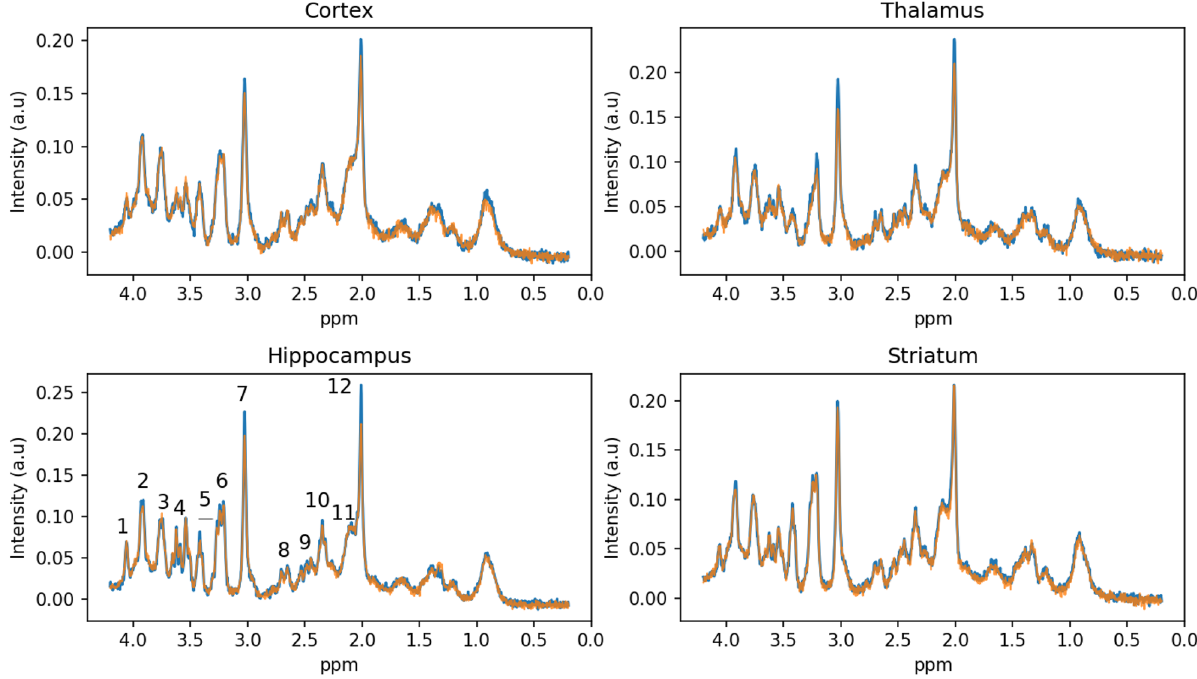
Figure 2. Regional metabolic profiles in aged rats. Average MRS profiles for each of the four brain regions evaluated in the WT (blue) and TgF344-AD (orange) cohorts at 18 months of age. Peaks corresponding to the main metabolites are indicated in the hippocampus profile: 1, myo-inositol (Ins); 2 and 7, total creatine (tCr); 3 and 11, glutamate + glutamine pool (Glx); 4, myo-inositol and glycine (Ins+Gly); 8 and 12, total N-acetylaspartate (tNAA); 5, taurine (Tau); 6, choline compounds (tCho); 9, glutamine (Gln); 10, glutamate (Glu). For quantitative information of median and interquartile range of the metabolite peaks, see Supplementary Table